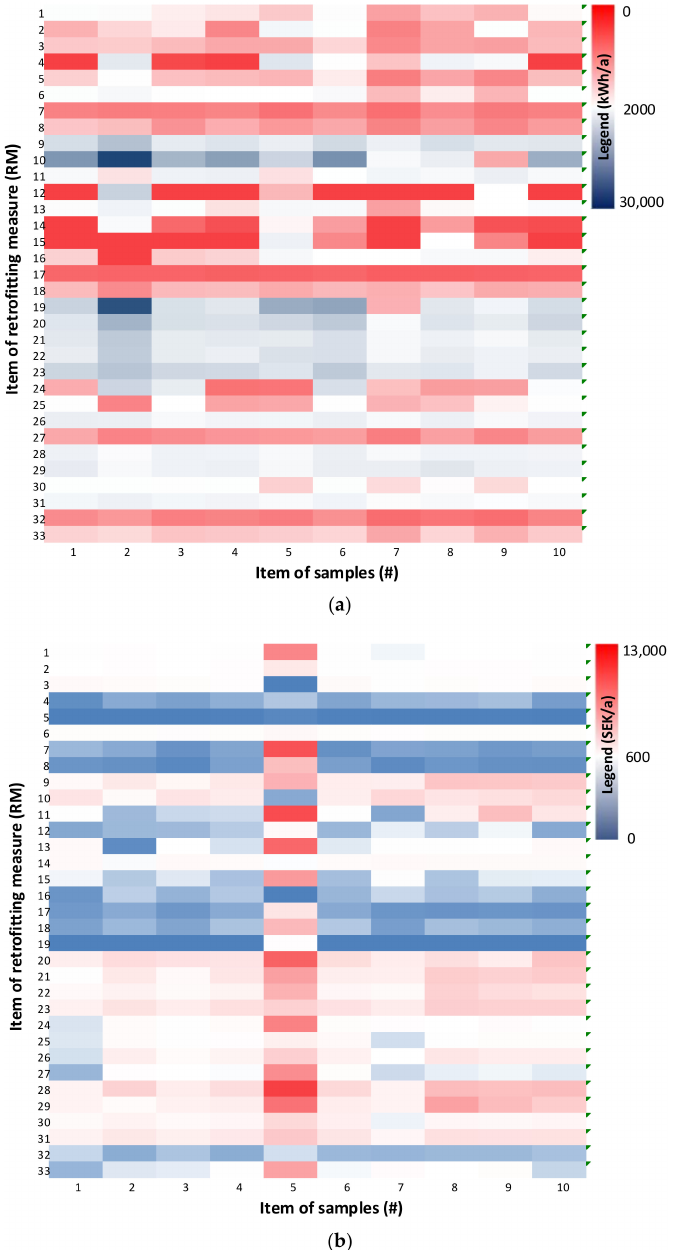
Figure 6. The energy-saving and cost of sample buildings under different retrofitting measures: ( a ) energy-savings of sample buildings and ( b ) cost of sample buildings; the color legend is not evenly